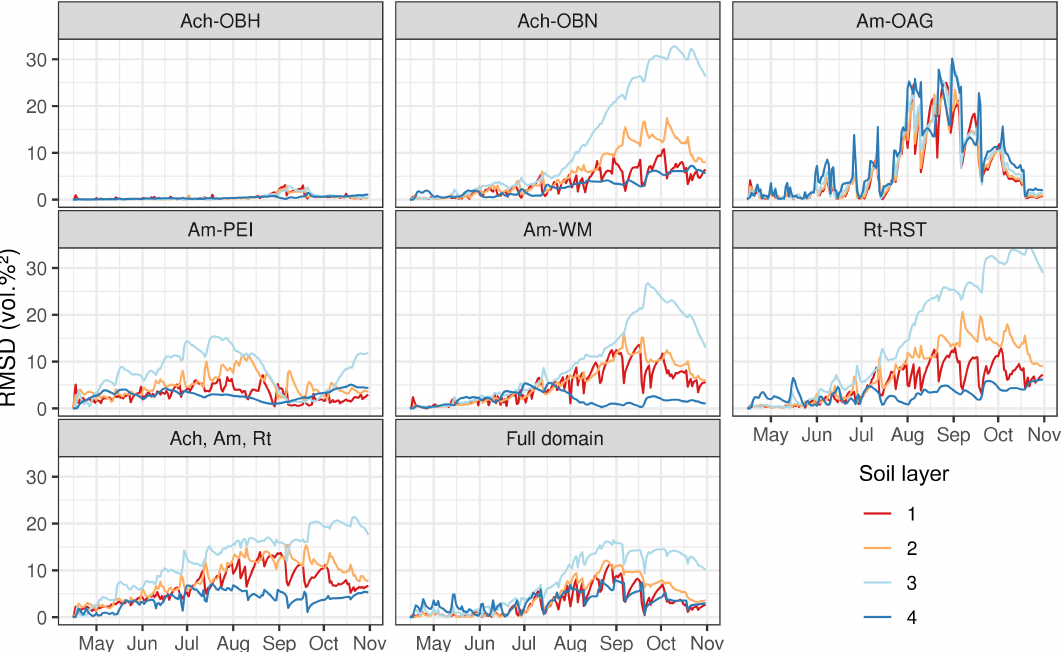
Figure 15. Time series of root mean square deviations between empirical variograms of WRF_SA and WRF-H_FC for soil moisture layers 1 to 4, based on 10 equidistant lags (1 to